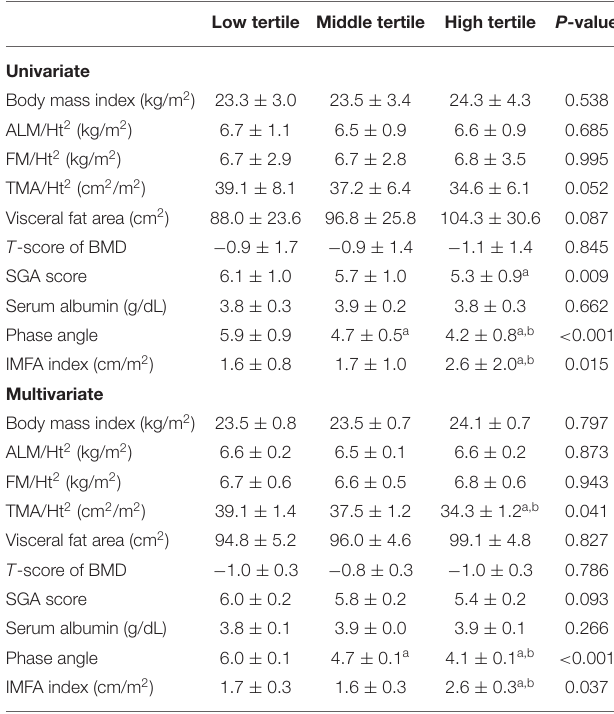
TABLE 2 | Comparison of body composition and nutritional indices according to edema index tertile. Low tertile Middle tertile High tertile P